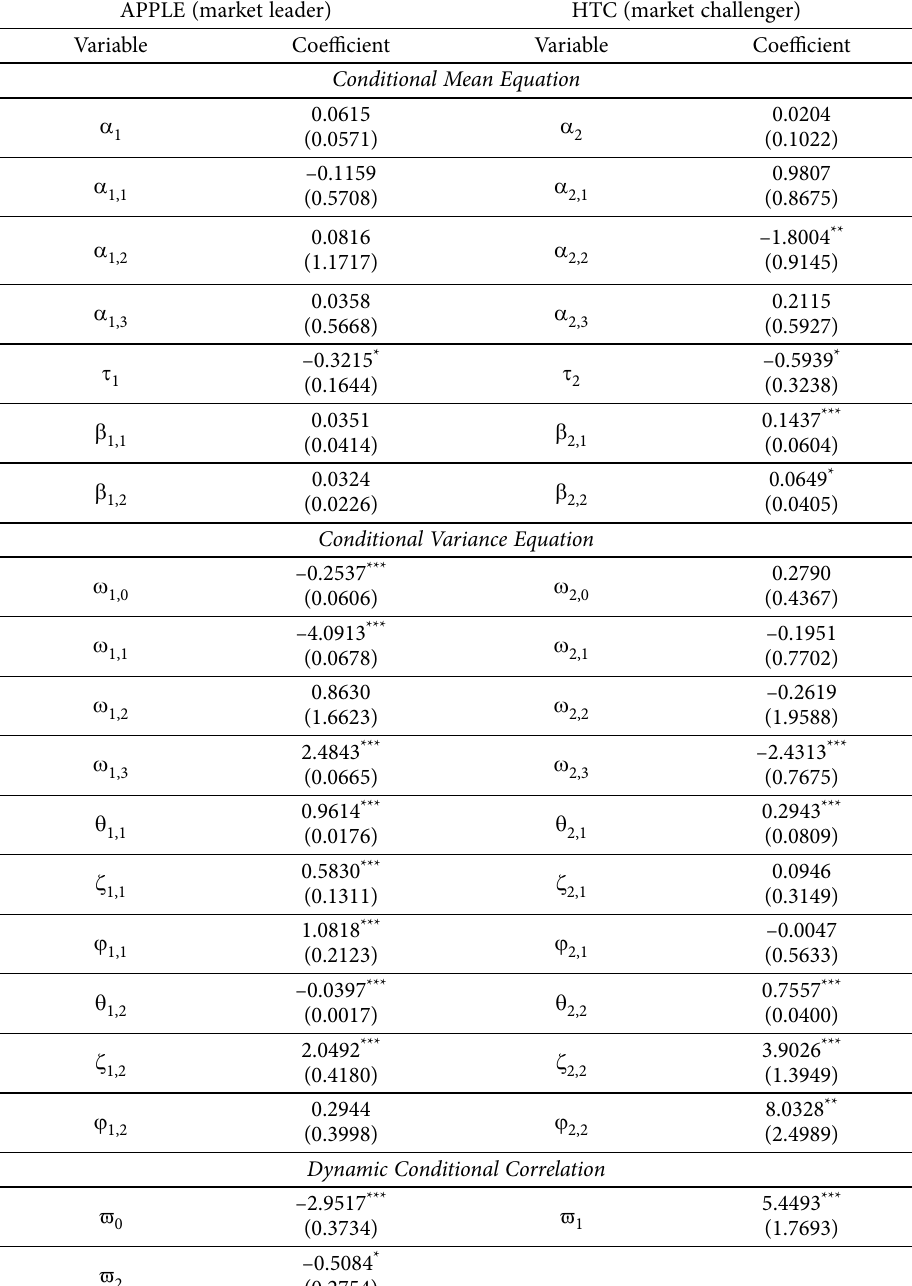
Table 2. Dynamic risk of patent infringement within market